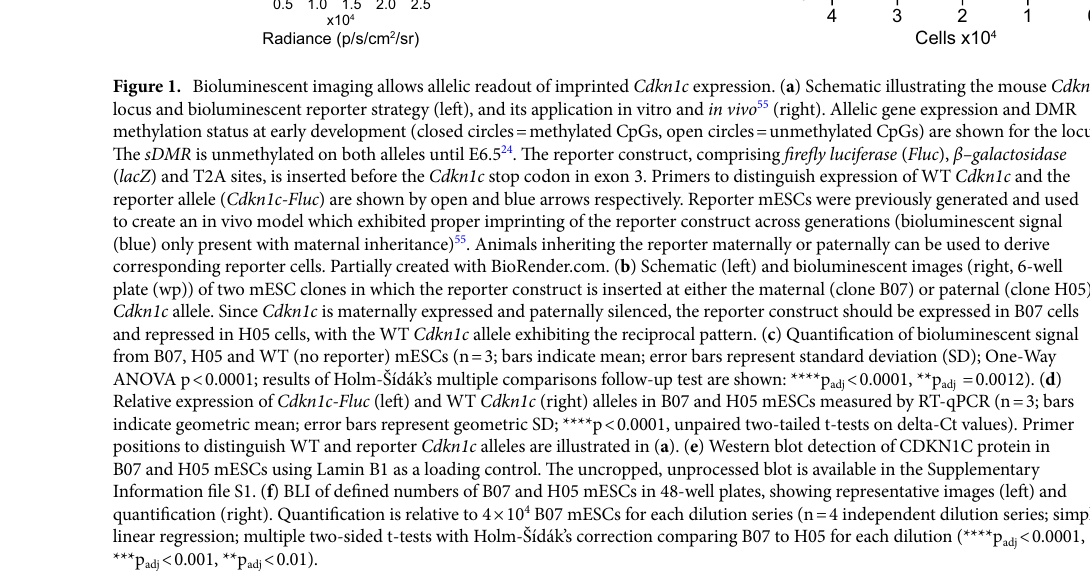
B07 (r² = 0.99) H05 (r² = 0.97)